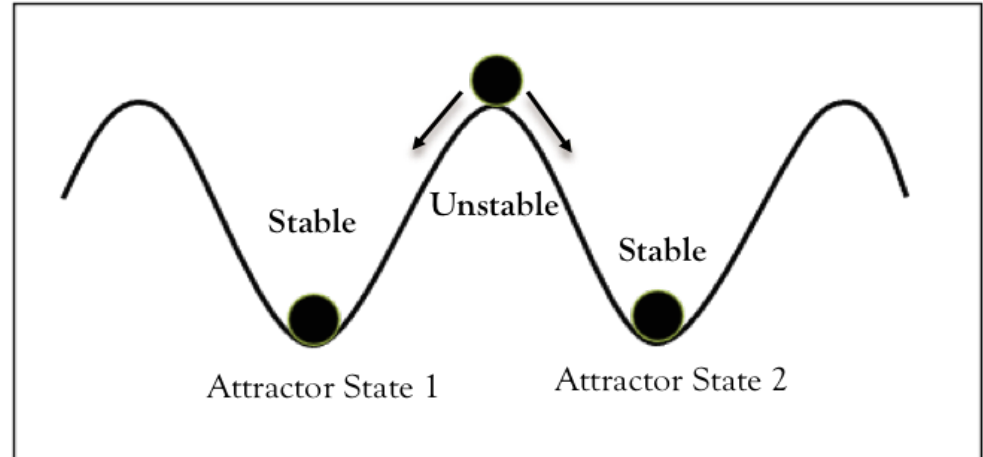
Figure 1. Attractor “landscape” adapted from Dilts (1998) [38].